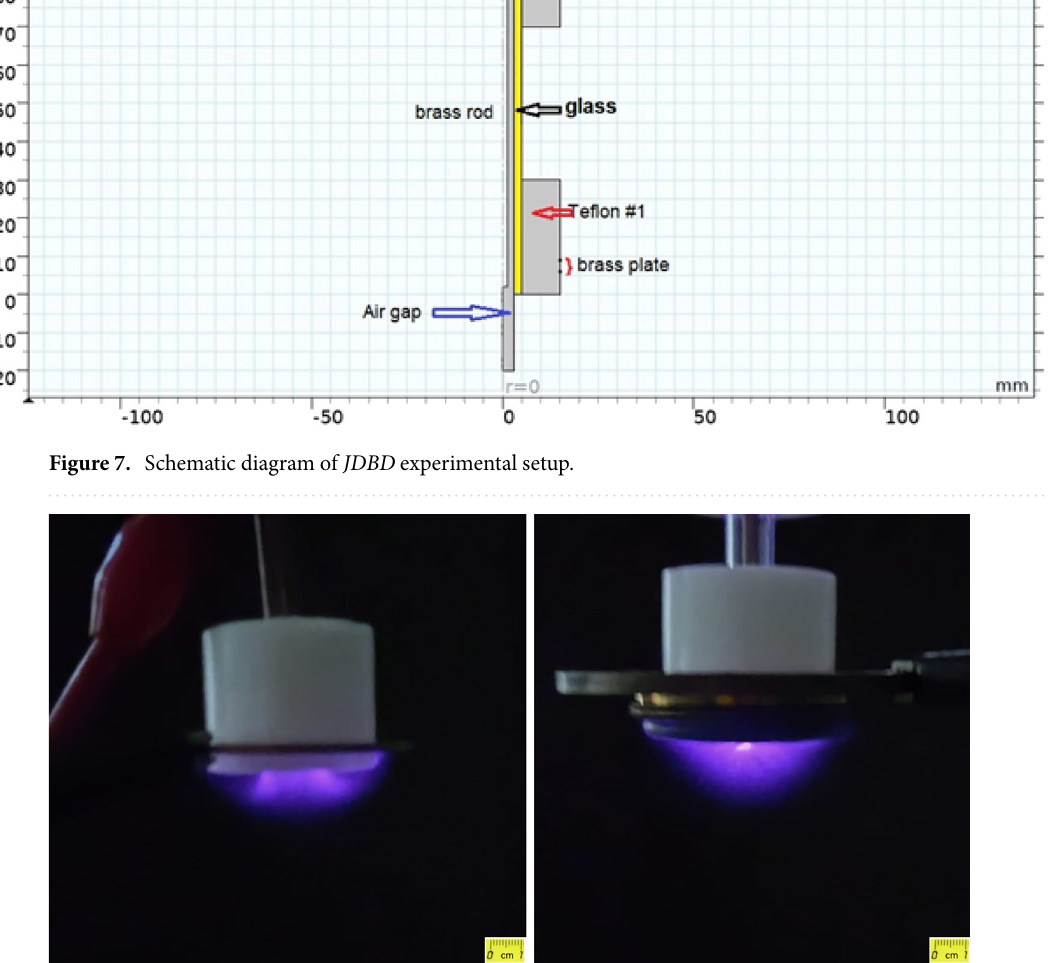
Figure 8. Large-scale JDBD plasma: hollow (left) and solid (right) central